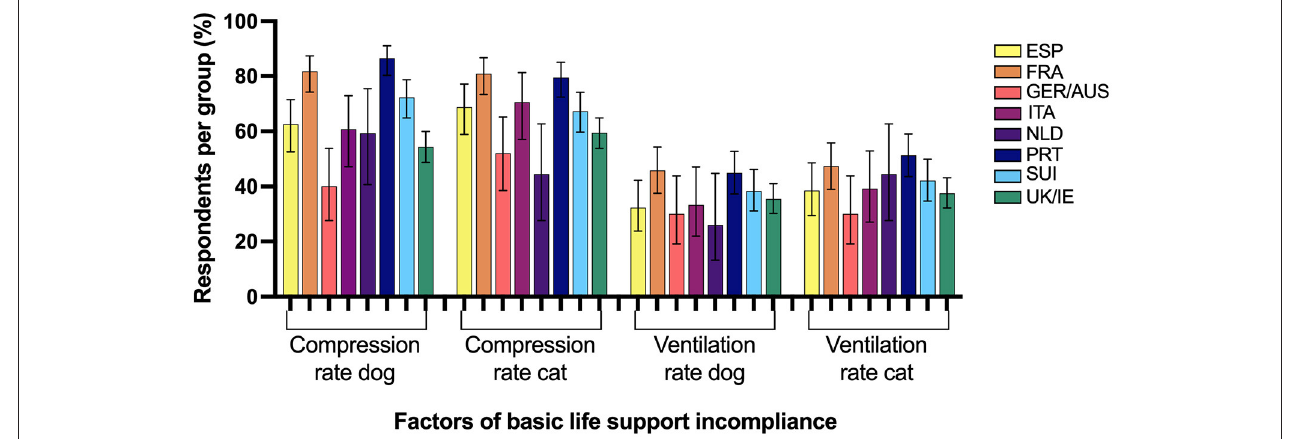
FIGURE 4 | Percentage of respondents from 8 Western European regions incompliant with basic life support RECOVER guidelines and the associated factors for failed compliance. ESP, Spain; FRA, France; GER/AUS, Germany/Austria; ITA, Italy; NLD, Netherlands; PRT, Portugal; SUI, Switzerland; UK/IE, England/Northern Ireland/Scotland/Wales/Ireland.